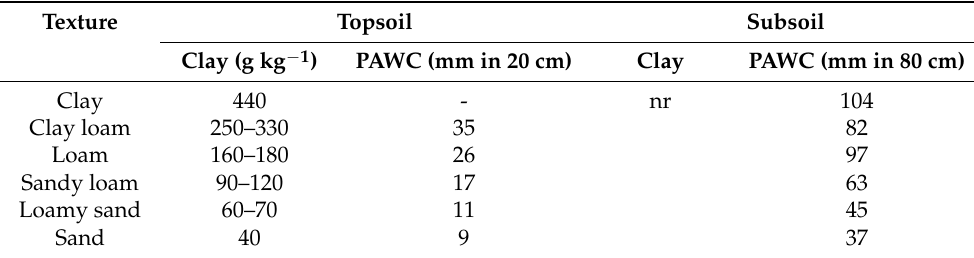
Table 7. Plant-available water content (PAWC) of topsoil (0–20 cm) and subsoil (20–100 mm depth), grouped by soil texture class for profile data from Savannahket, Laos